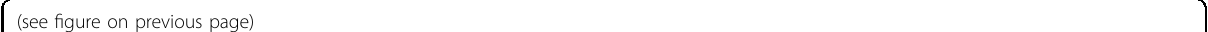
Fig. 3 Infusion of ex vivo polarized BMDMs alters macrophage polarization and CER metabolism in the liver after partial hepatectomy. Mouse livers after hepatectomy were infused with phosphate buffer saline (PBS) (Veh), M0, M1, and M2 BMDMs. The remnant liver tissues were collected at postoperative day 2 (POD2) to examine macrophage polarization and levels of CER metabolites. A Liver tissues were harvested at 2 days and 4 days after GFP-positive polarized BMDM infusion. Liver sections were stained with anti-GFP (green), anti-F4/80 (macrophage marker, red), anti- Inos (M1 marker, yellow), and anti-CD206 antibodies (M2 marker, yellow) to validate the in fi ltration of polarized BMDM in the remnant liver after hepatectomy by confocal scanning. DAPI was used to visualize nuclei (blue). B , C Liver sections were co-stained with F4/80 (red) and iNos (green) ( B ) or CD206 (green) ( C ) to examine M1 or M2 macrophage polarization in response to BMDM infusion in the remnant liver after hepatectomy. DAPI was used to visualize nuclei (blue). D M1 and M2 macrophages in the remnant liver tissues were counted in fi ve random 20× fi elds to quantify alteration in M1 and M2 polarization by BMDM infusion in the remnant liver after hepatectomy. E , F Total RNA was extracted from the remnant liver tissues, then mRNA levels of M1-macrophage-associated genes ( Tnf- α , Inos , and Il-6 ) ( E ) and M2-macrophage-associated genes ( Fizzl , Arg1 , Il-4 , and Il-10 ) ( F ) were determined by qPCR. G , H Levels of CER metabolites were determined in the remnant liver tissues with BMDM infusion after hepatectomy, including d18:1-CER ( G ), d18:1-SPH ( H ), and d18:1- S1P ( H ) by targeted UHPLC-ESI-MS/MS. Images in A – C represent results from fi ve individual mice in each group. Data in E – H are demonstrated as mean ± SD, n = 5 – 6; * p < 0.05, ** p < 0.01, *** p <